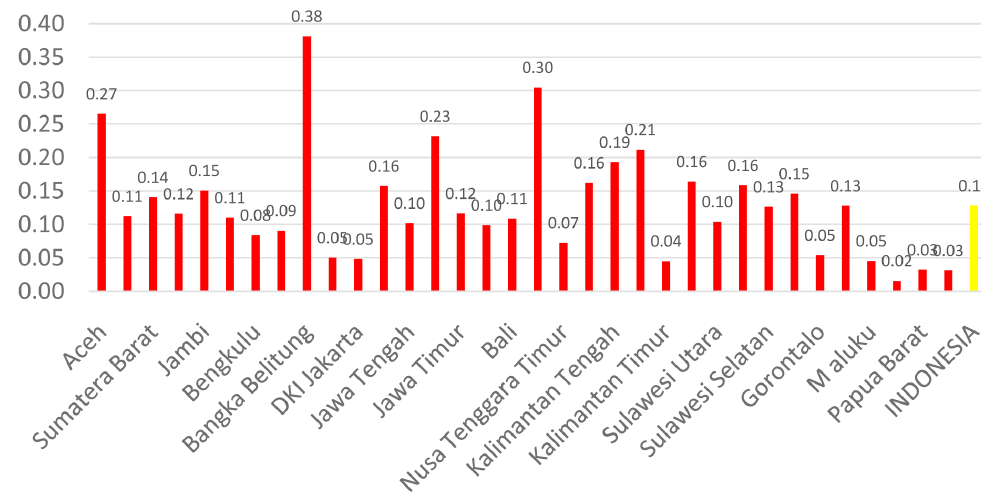
center.Figure 3. Average number of dental therapists at every Province in each public health